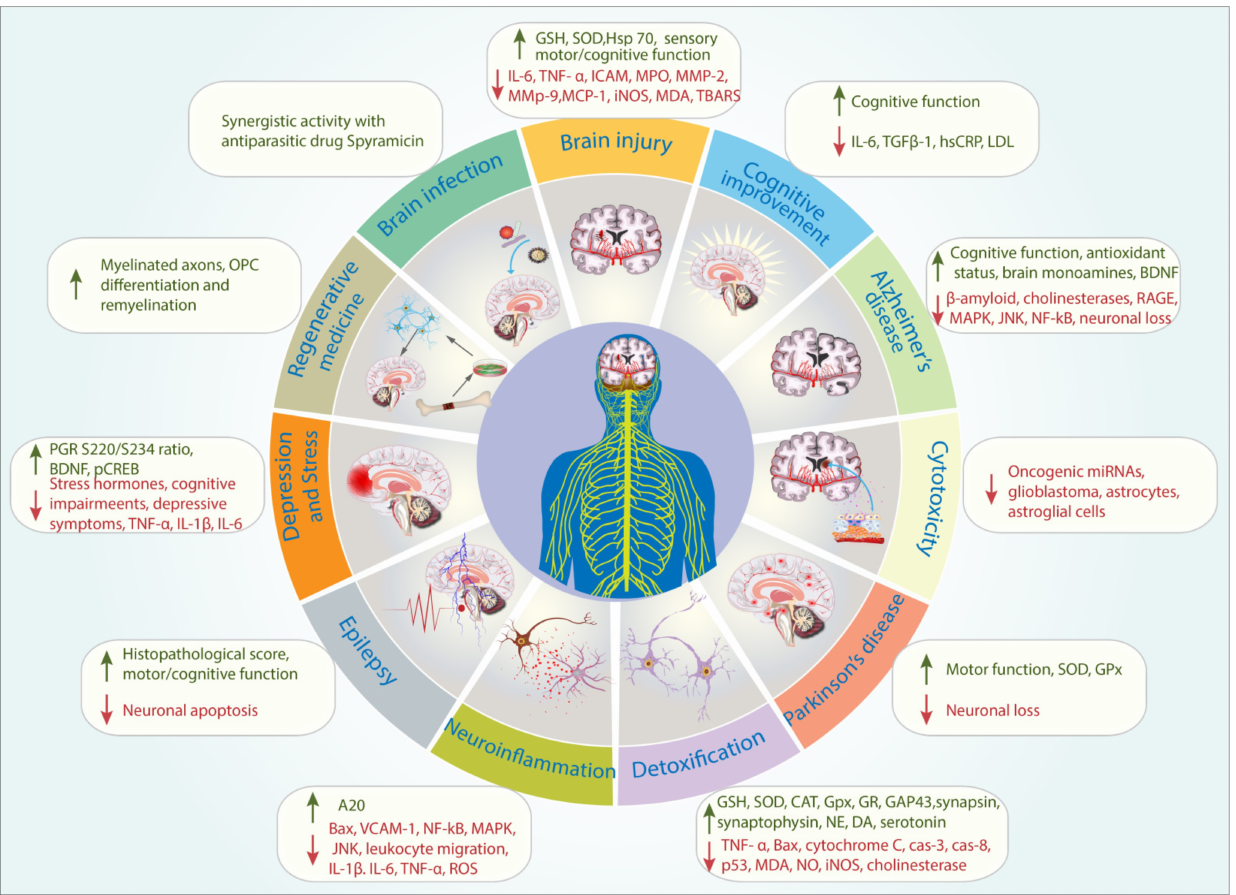
Figure 4. The potential use of propolis in treating brain and neurological injuries and disorders and its mode of action based on the latest experimental data. Green and red arrows indicate increased and reduced activity/expression,